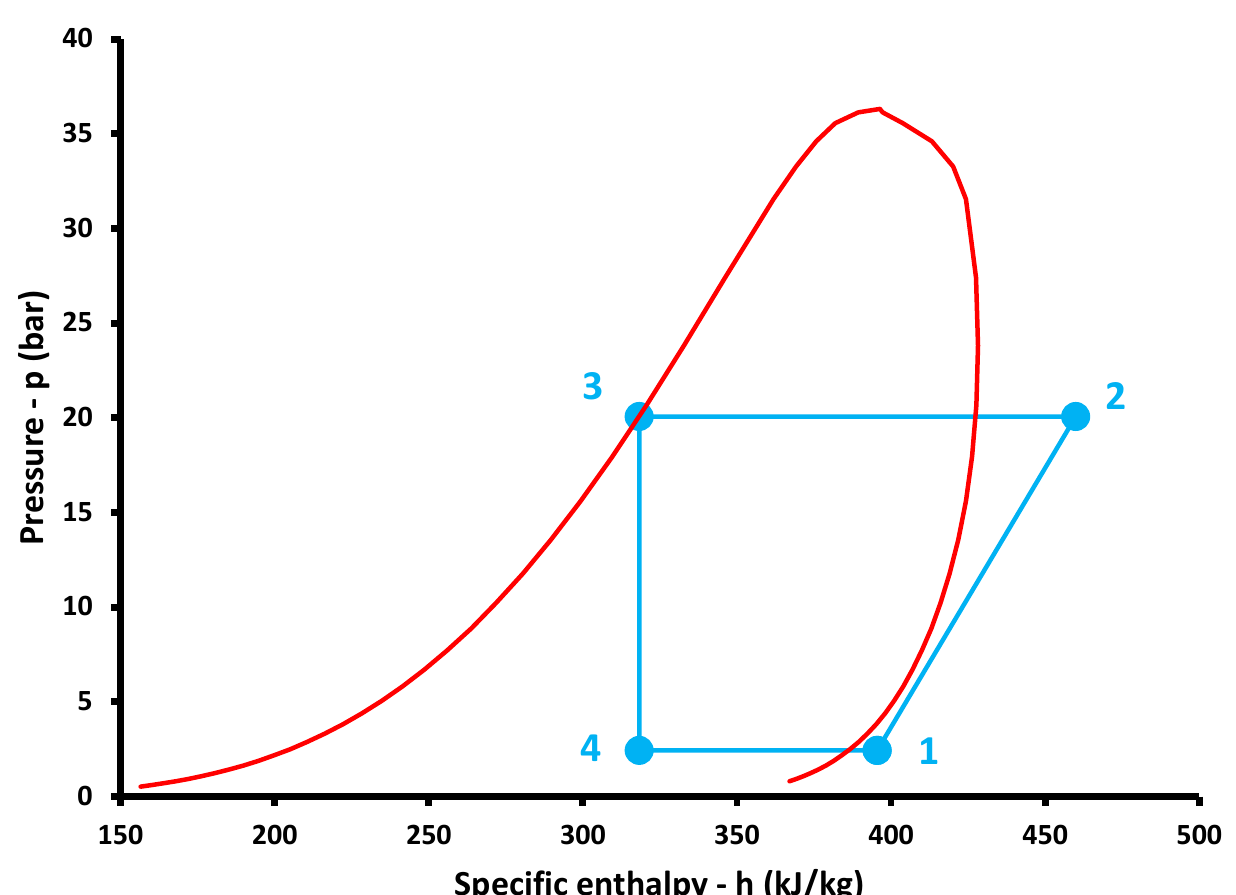
Figure 8. Pressure–specific enthalpy depiction (p–h) of the heat pump cycle for the case with ambient temperature at 10 °C.